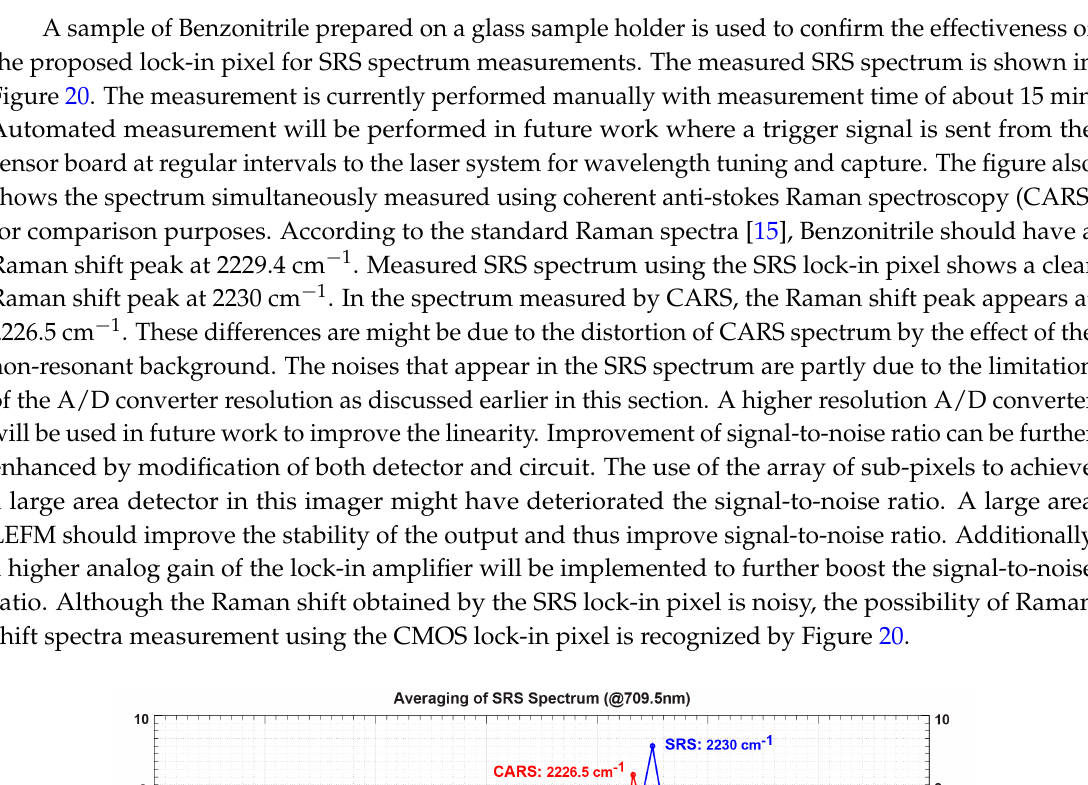
Figure 19. Small signal detection linearity.